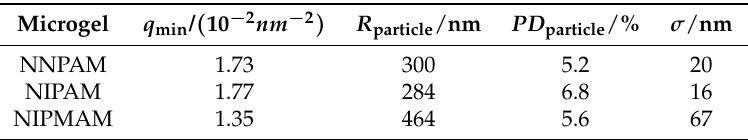
Table 2. Results from the fit of the experimental static light scattering (SLS) data from the homopolymer microgels with the fuzzy sphere form factor model.